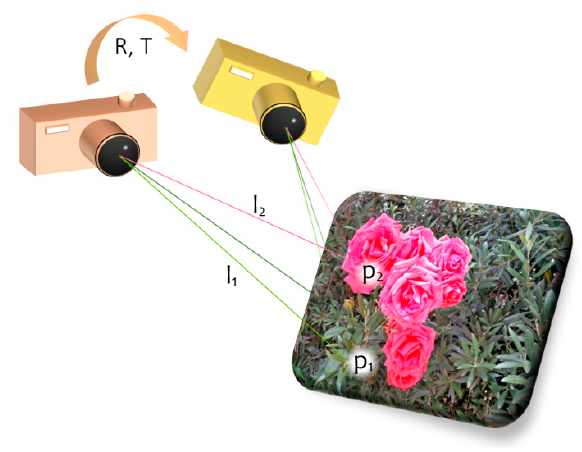
Figure 1. Illustration of the PNP problem.